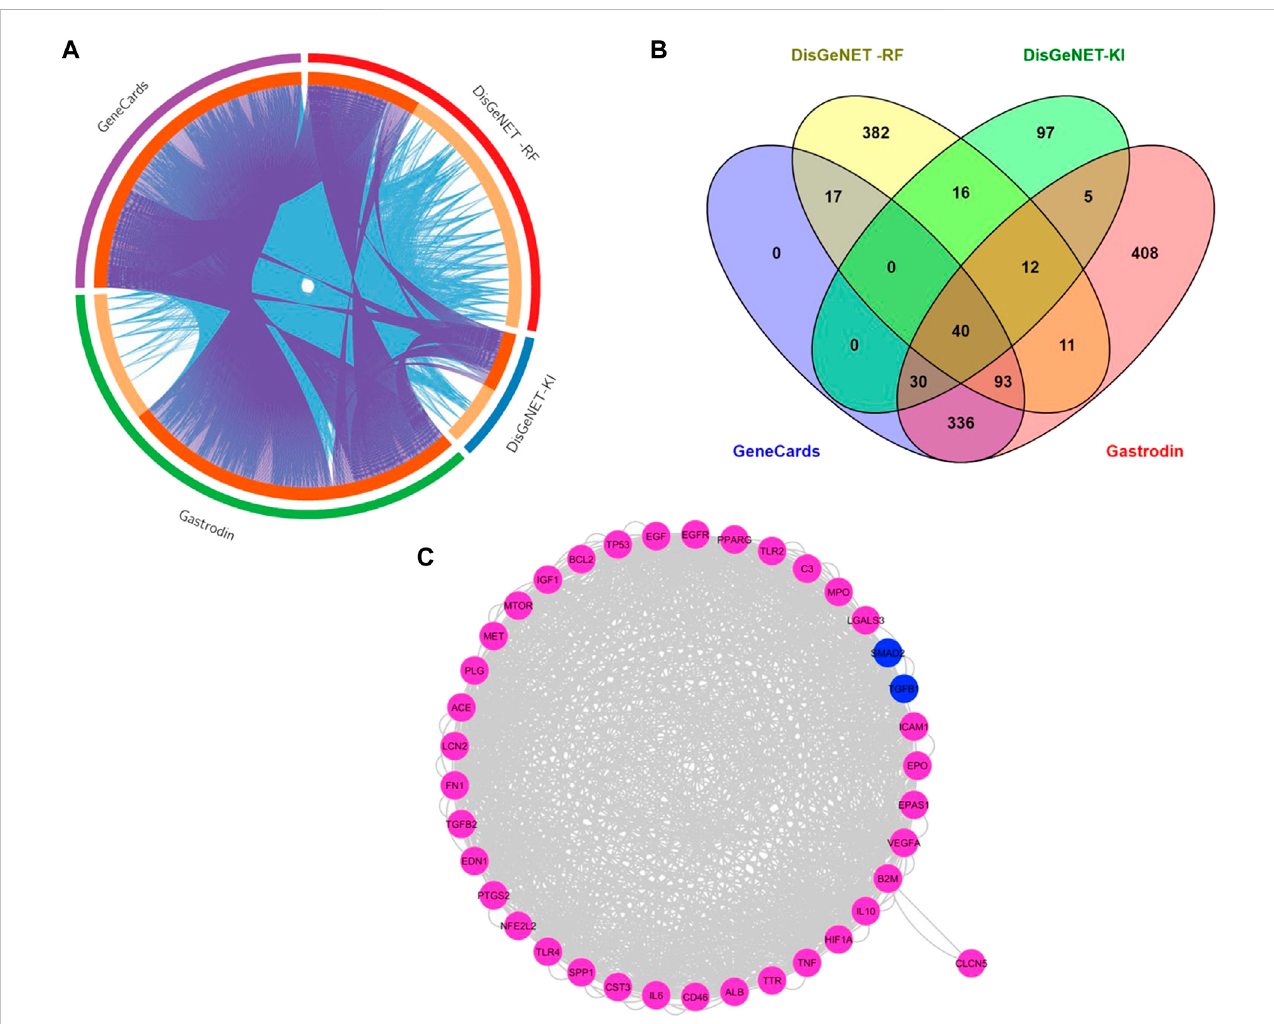
FIGURE 3 Network of Protein-Protein Interactions (PPI) of common targets between gastrodin and renal fi brosis targets (A) The Circos plot shows intersecting genes. The outer arcs symbolize the identity of each gene. Each of the inside arcs represents a gene, and each gene is represented by its ownspot on the